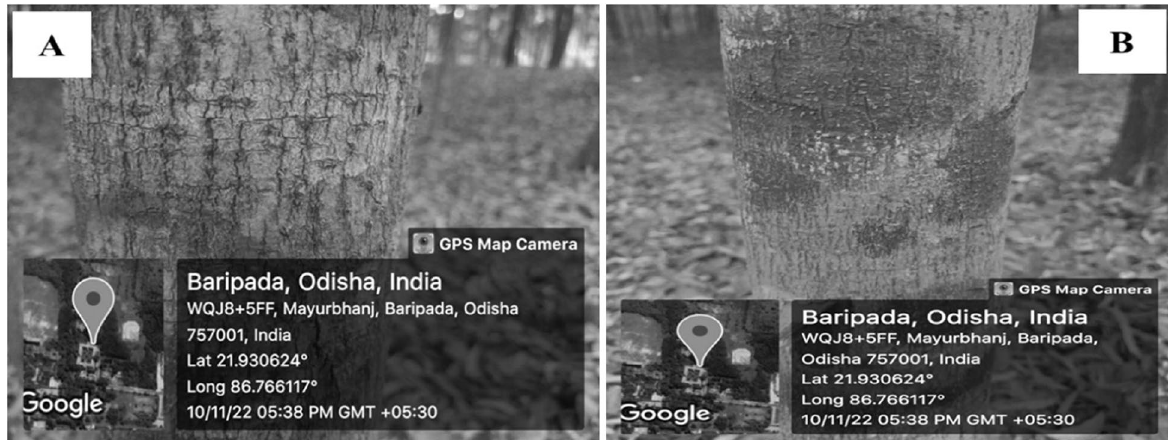
Fig. 3 Field photography of Lichens in natural habitat A Phaeographis dendritica and B Trypethellium